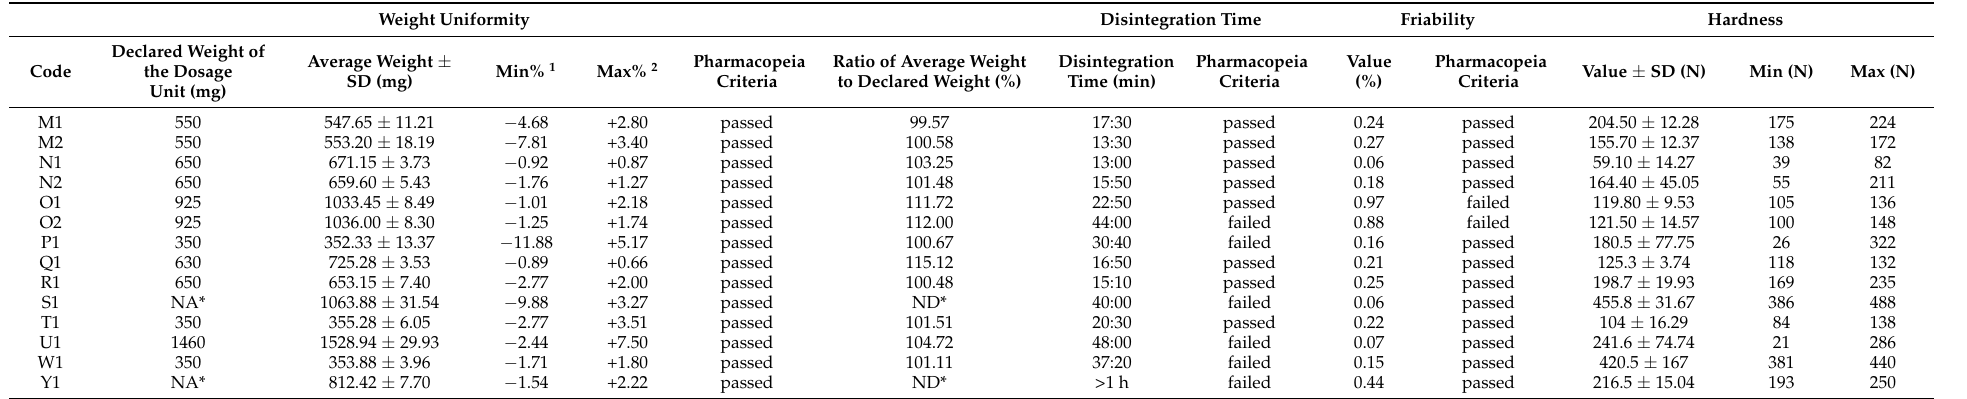
Table 2. Physical parameters of supplements in tablet